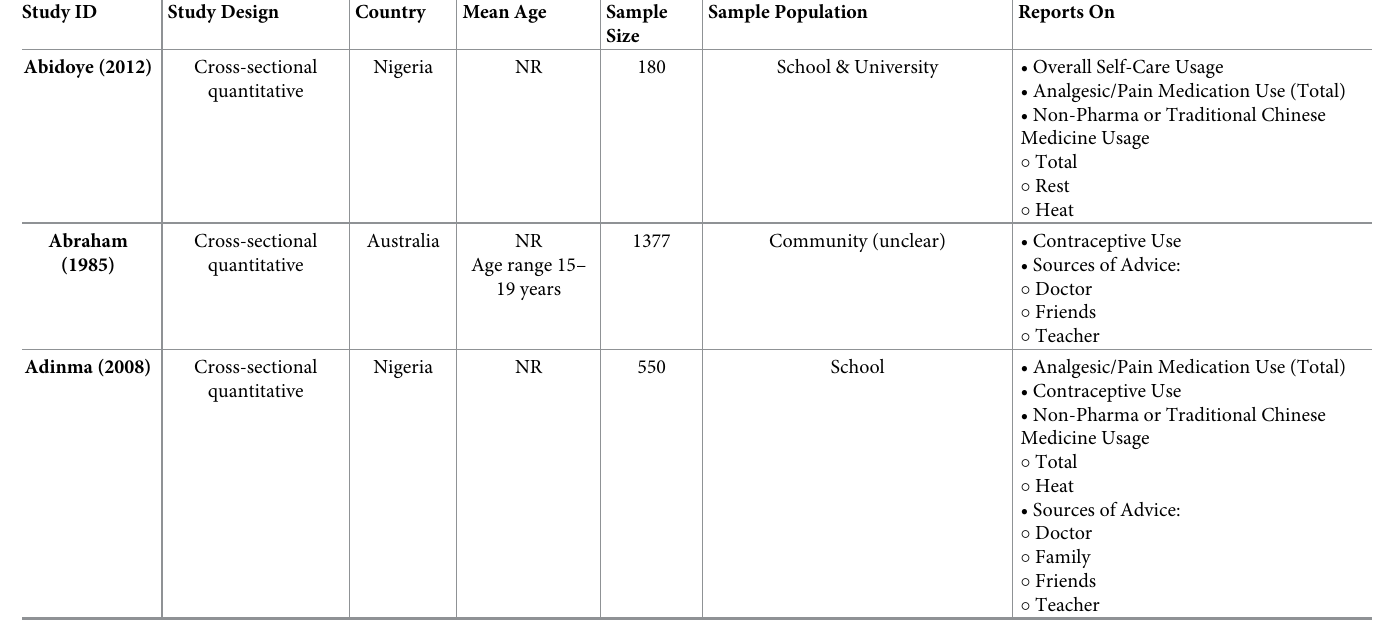
Table 1. Characteristics of included